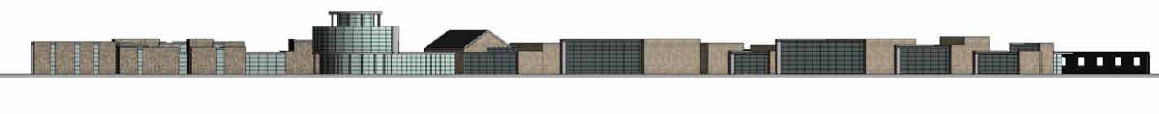
fig. 5c. The new buildings between the walls of the city and the Bacchiglione river bank. front on the river (Bellotto, Bronca 2015)